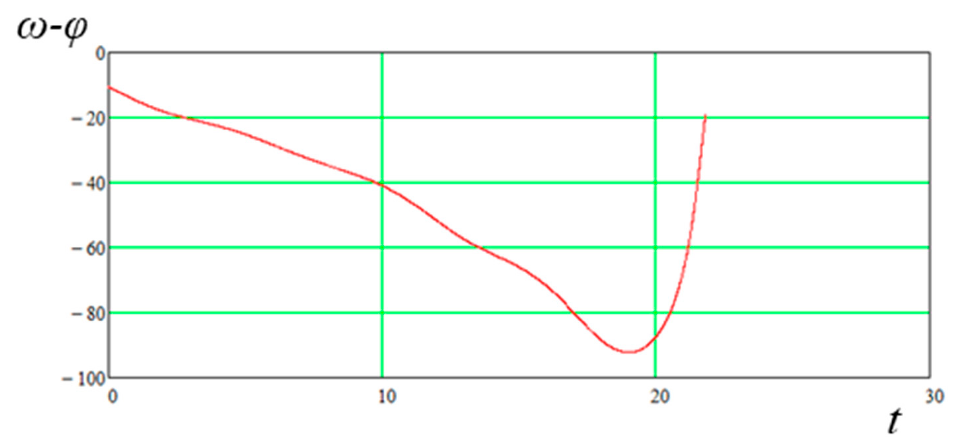
Figure 13. Dependence of the angle between the Laplace vector of the transfer orbit and the current direction to the Sun.